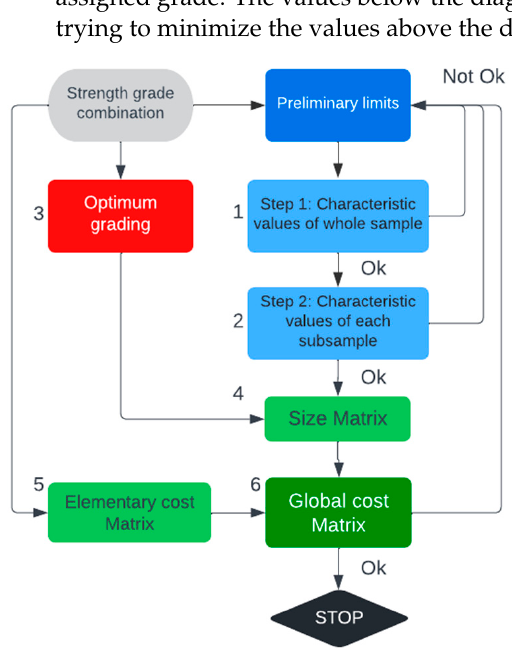
Figure 5. IP limits derivation process.